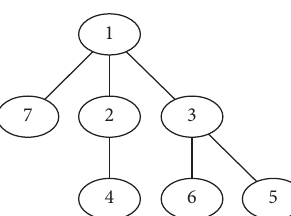
Figure 5: Prufer sequence examples: decoded tree for 2 , 1 , 3 , 3 , 1 as a Prufer sequence.